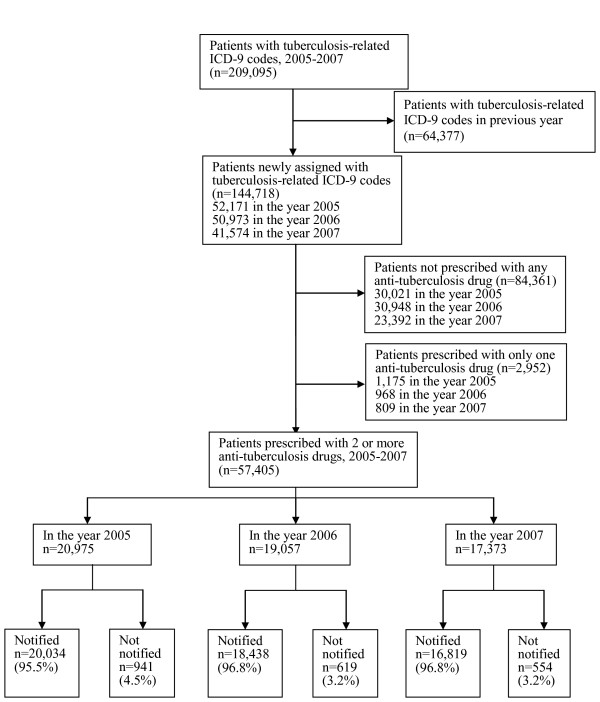
Flow chart of ascertainment of notification of tuberculosis patients reimbursed by national health insurance in Taiwan, 2005-2007.